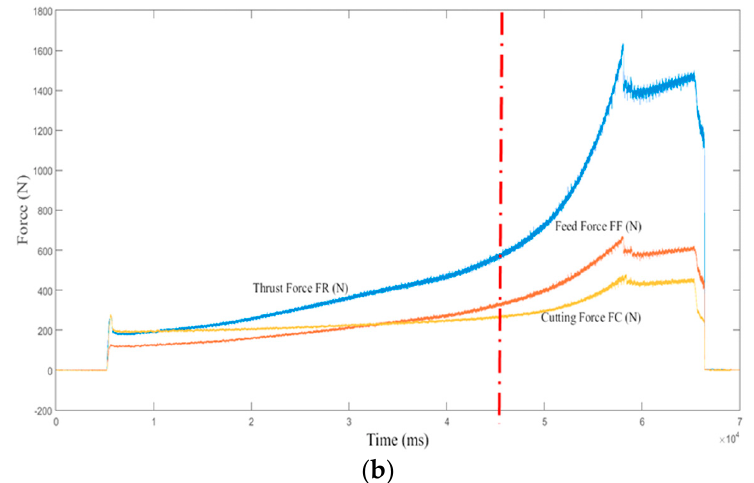
Figure 7. ( a ) Flank wear (VB); ( b ) cutting forces profile of insert TS2500 in 60 s of cutting.